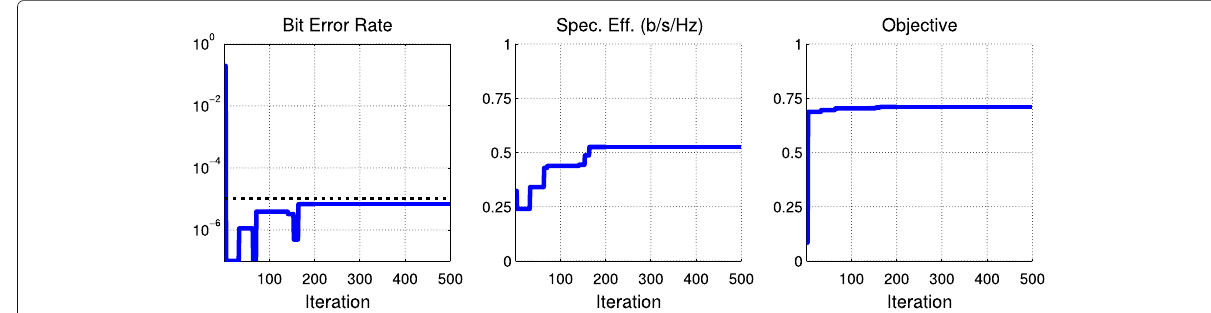
Fig. 12 The BER, spectral efficiency, and objective per iteration for the simulated annealing algorithm with a target BER of 10 − 4